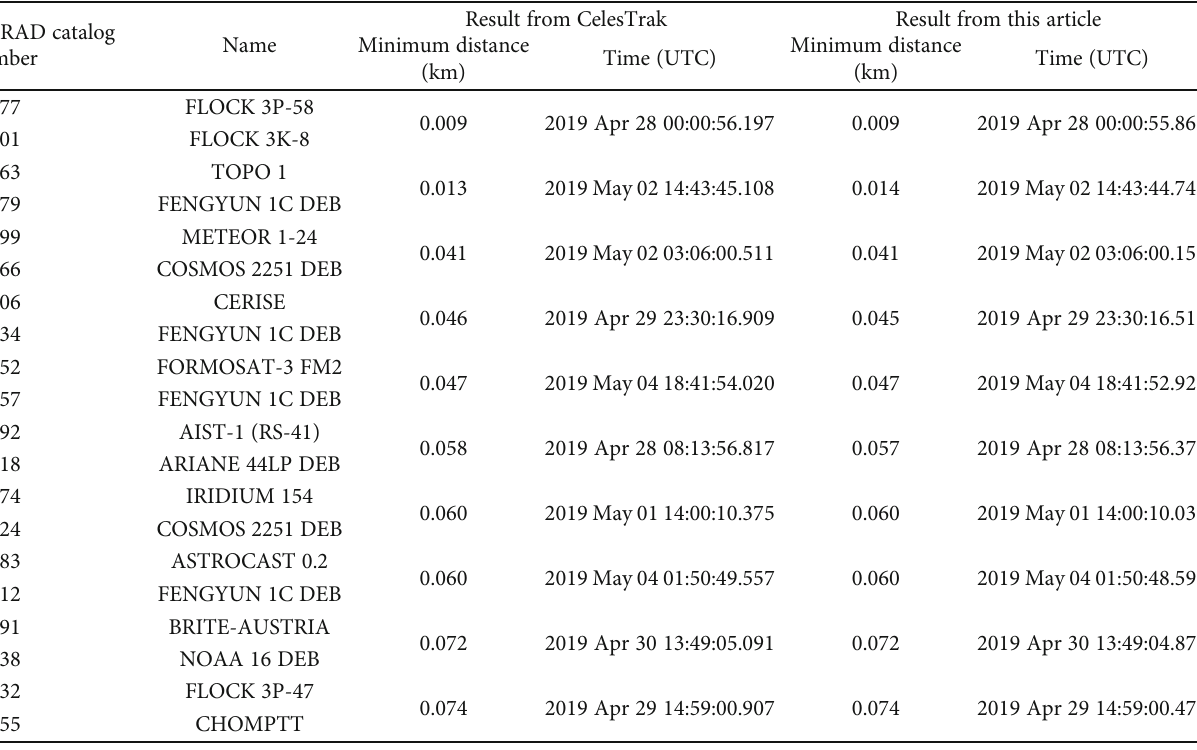
Table 6: Comparison of the result. Data current as of April 28, 2019, 00:06:00 UTC.